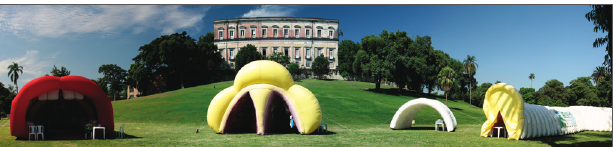
Figura 2. Visão panorâmica dos modelos anatômicos infláveis do ouvido, nariz e